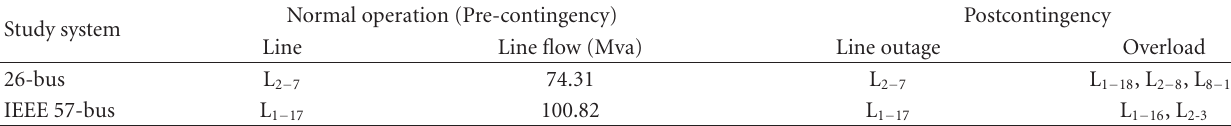
Table 3: System state under normal operation and